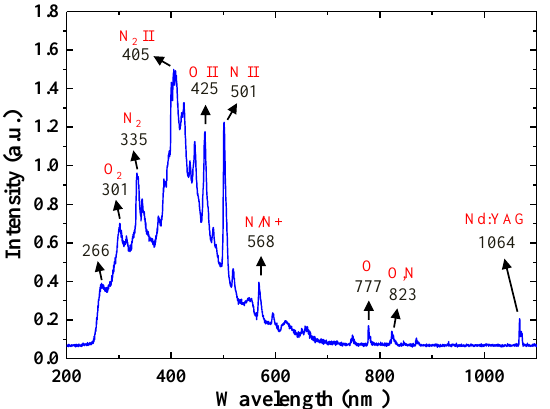
Figure 5. Time-averaged radiation spectrum of the induced plasma in air.